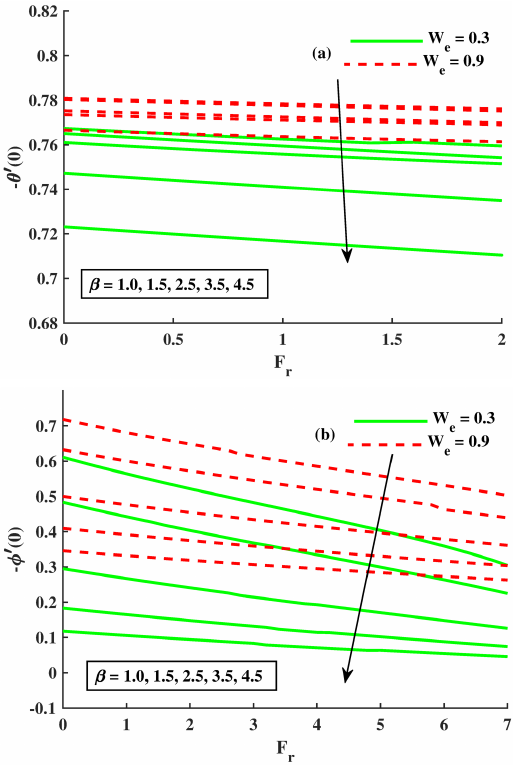
Figure 9. The effects of β , F r , & W e on Nusselt and Sherwood